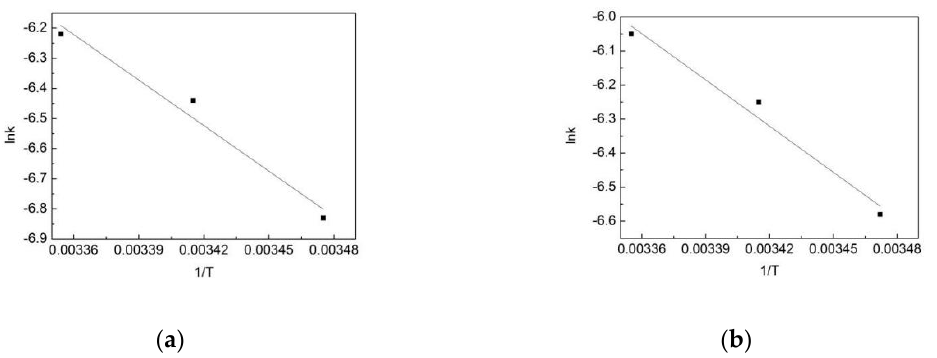
Figure 11. Arrhenius fitting of OFL chlorination by free chlorine (OOFC) in ( a ) the water distribution system, and in ( b ) the deionized water.